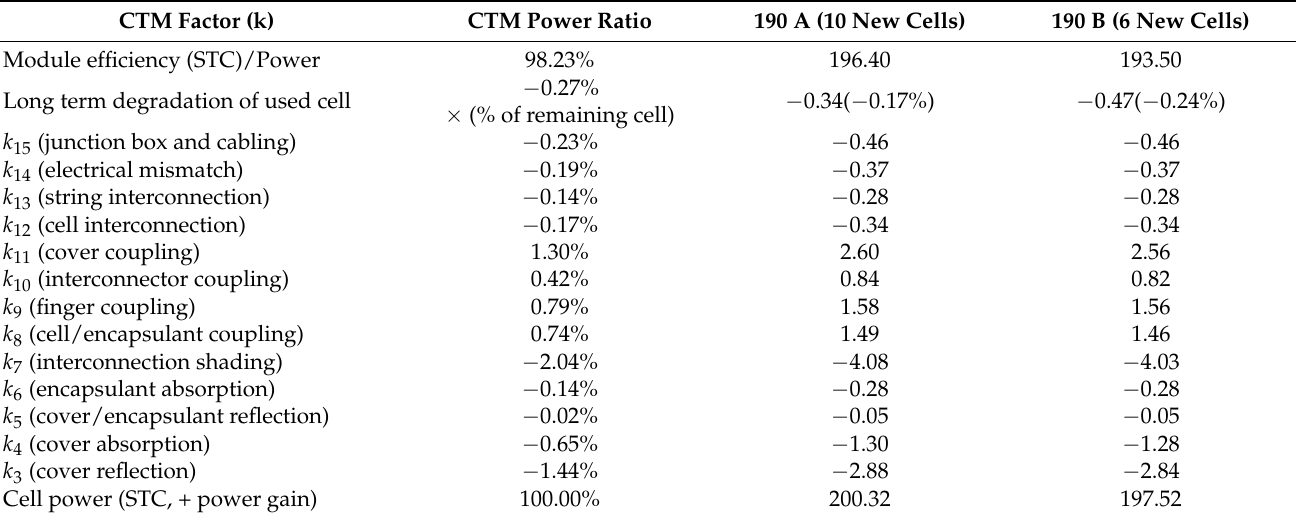
Table 5. Power output prediction for recovered